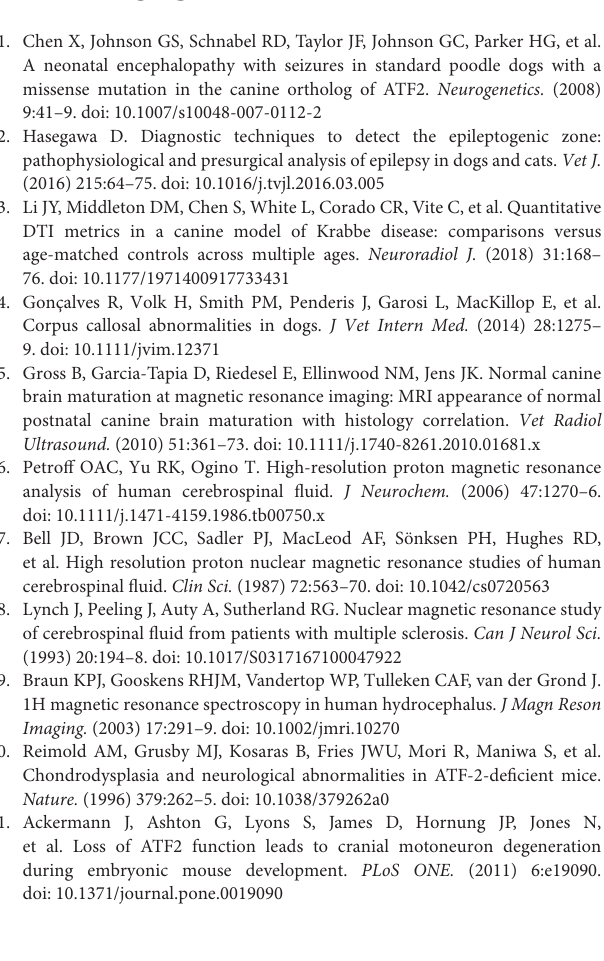
Supplementary Figure 1 | Spectrum of single-voxel proton magnetic resonance spectroscopy (H1-MRS) of the fronto-parietal lobe using short echo time